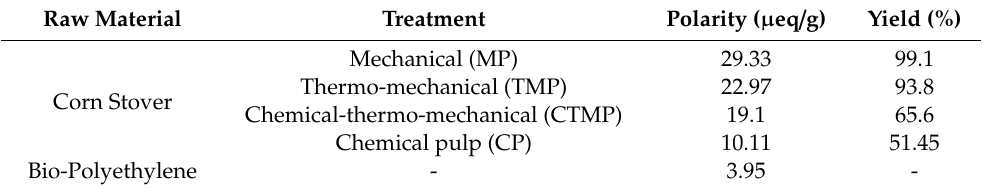
Table 1. Polarity and treatment yield of corn stover fibers and